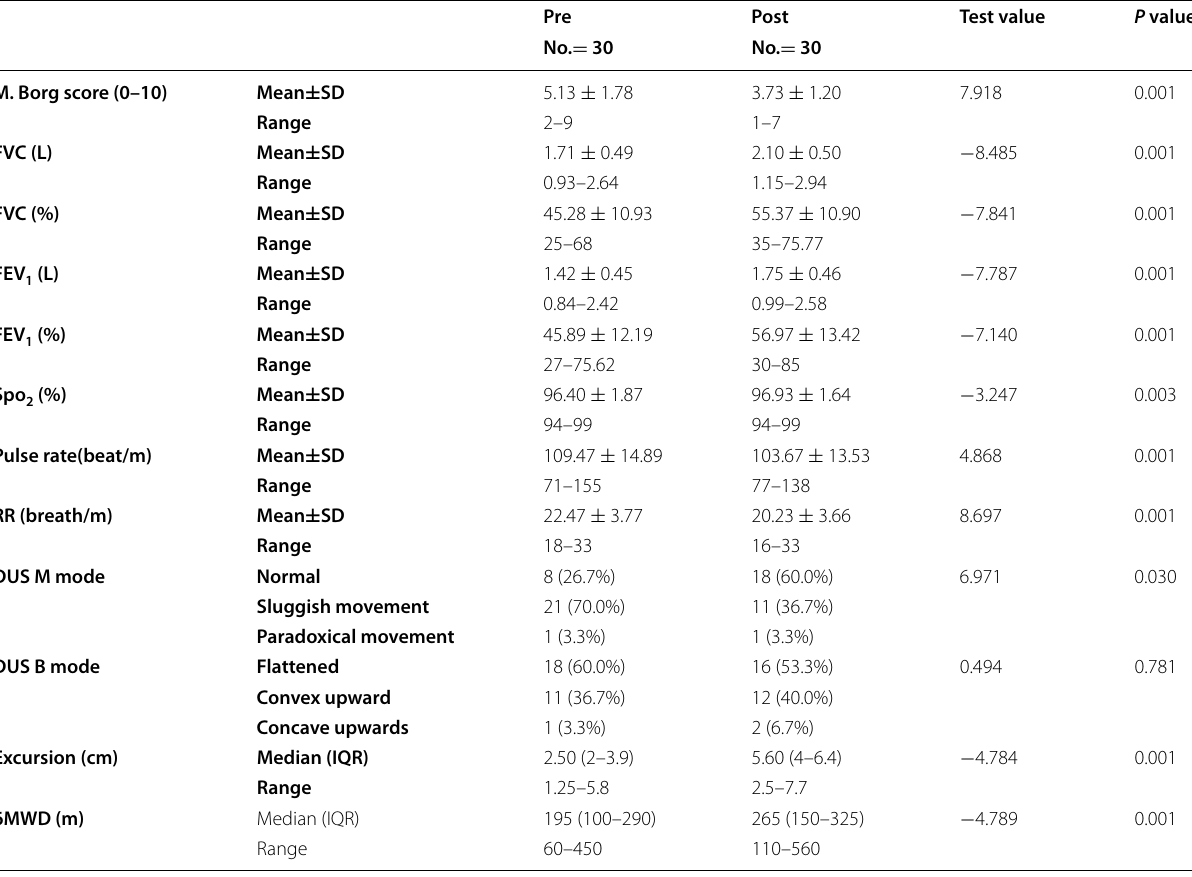
Table 4 Comparative functional assessment of the studied patients pre- and